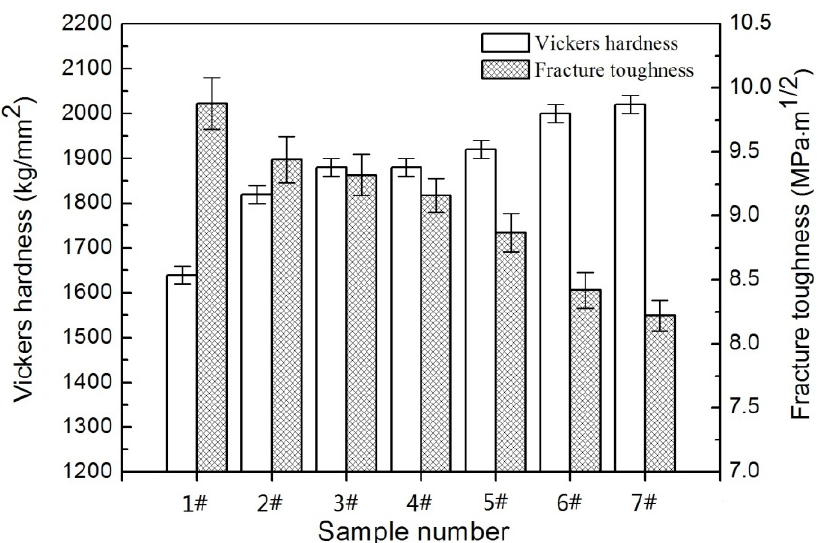
Figure 9. Vickers hardness and fracture toughness of WC–6Co–(Cr 2 C 3 /VC) cemented carbides sintered at 1450 ◦ C. 1#: WC–6Co; 2#: WC–6Co–0.25Cr 3 C 2 ; 3#: WC–6Co–0.6Cr 3 C 2 ; 4#: WC–6Co–1.0Cr 3 C 2 ; 5#: WC–6Co–0.25VC; 6#: WC–6Co–0.6VC; 7#: WC–6Co–1.0VC.